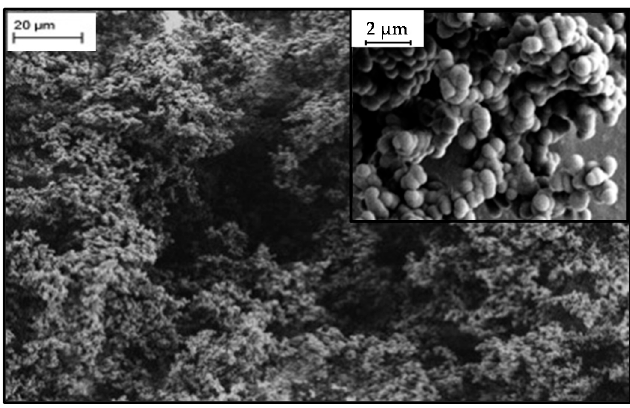
Figure 1. Microstructure of lf-RF aerogel with an average particle size of 0.45 µm and large pores of about 8.5 µm. C 2016 , 2 , 22